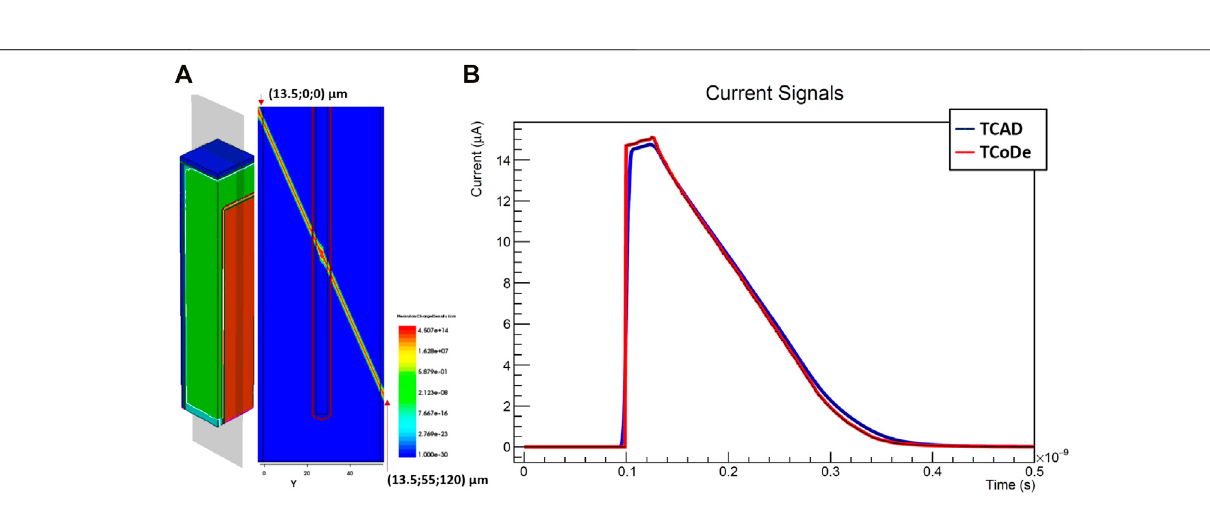
Frontiers in Physics |